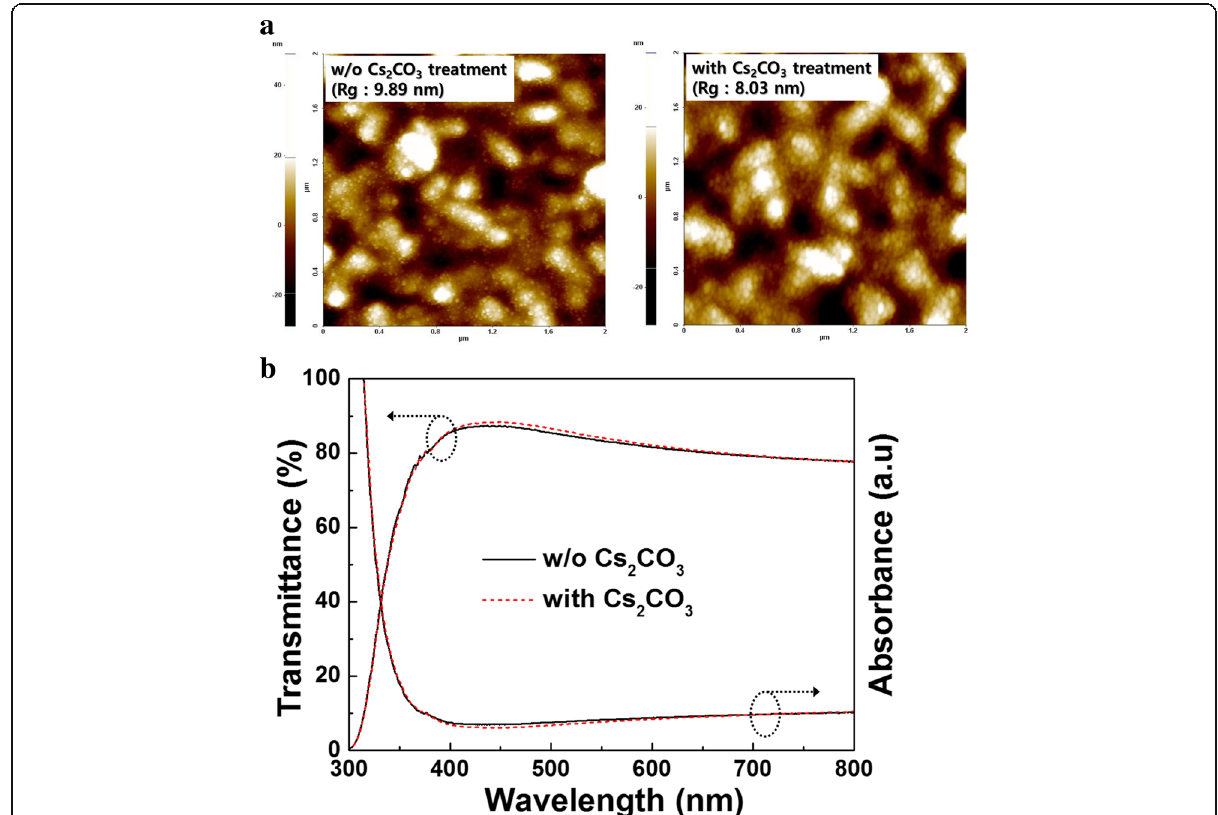
Fig. 6 a AFM images (2 μ m × 2 μ m) of the surface morphology and b UV-Vis absorption and transmission spectra of c-TiO 2 with and without Cs 2 CO 3